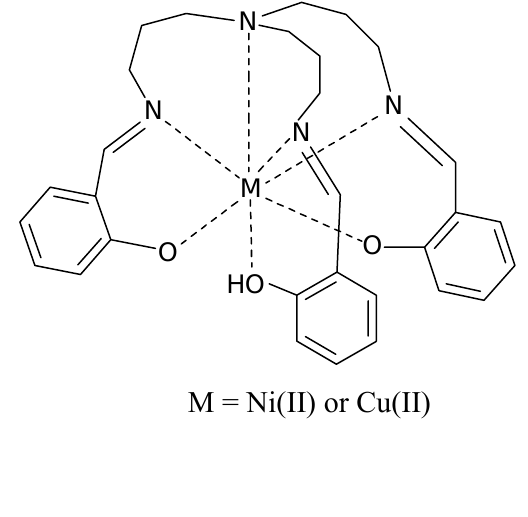
Figure 2. The proposed chemical structure for the complexes 1 and 2